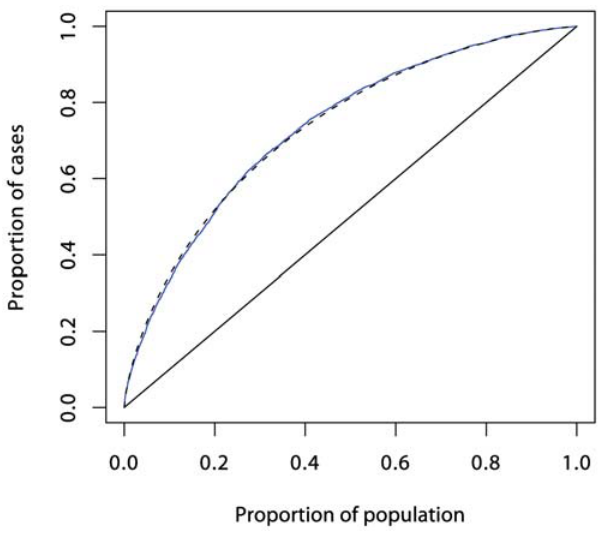
Figure 4. ROC curve prediction from the SNPs outside the MHC region listed in Supplementary Table 1 in Text S1 (in blue). The dashed curve corresponds to a polygenic multiplicative model with l s =1.48.